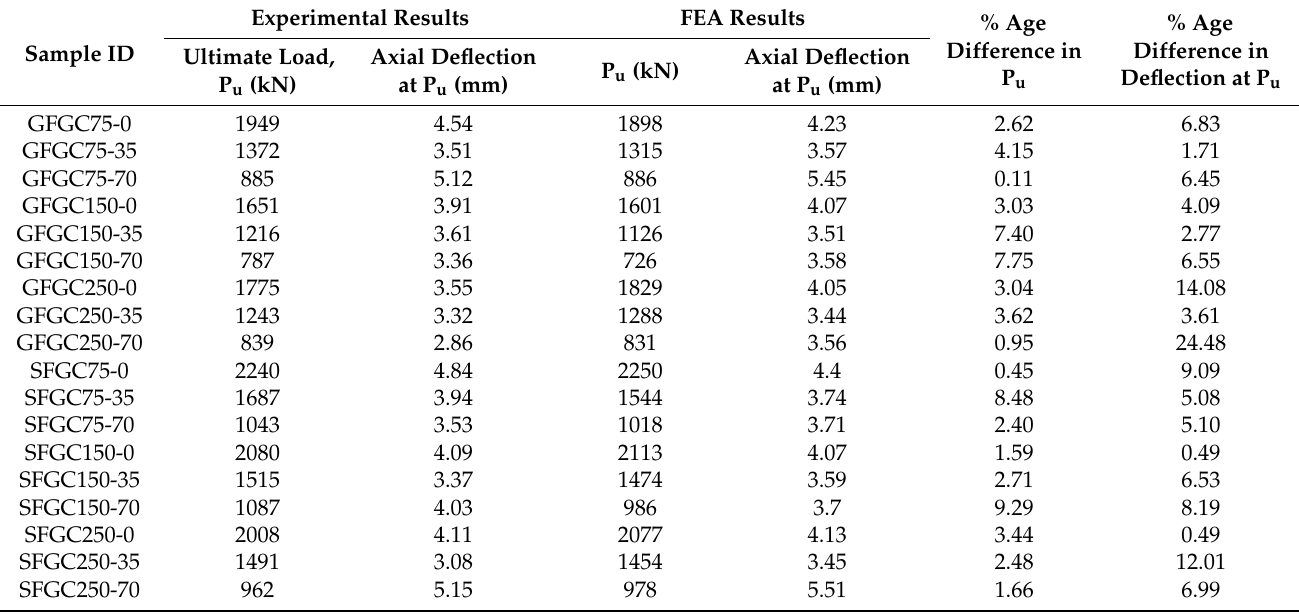
Table 5. Testing and FEA